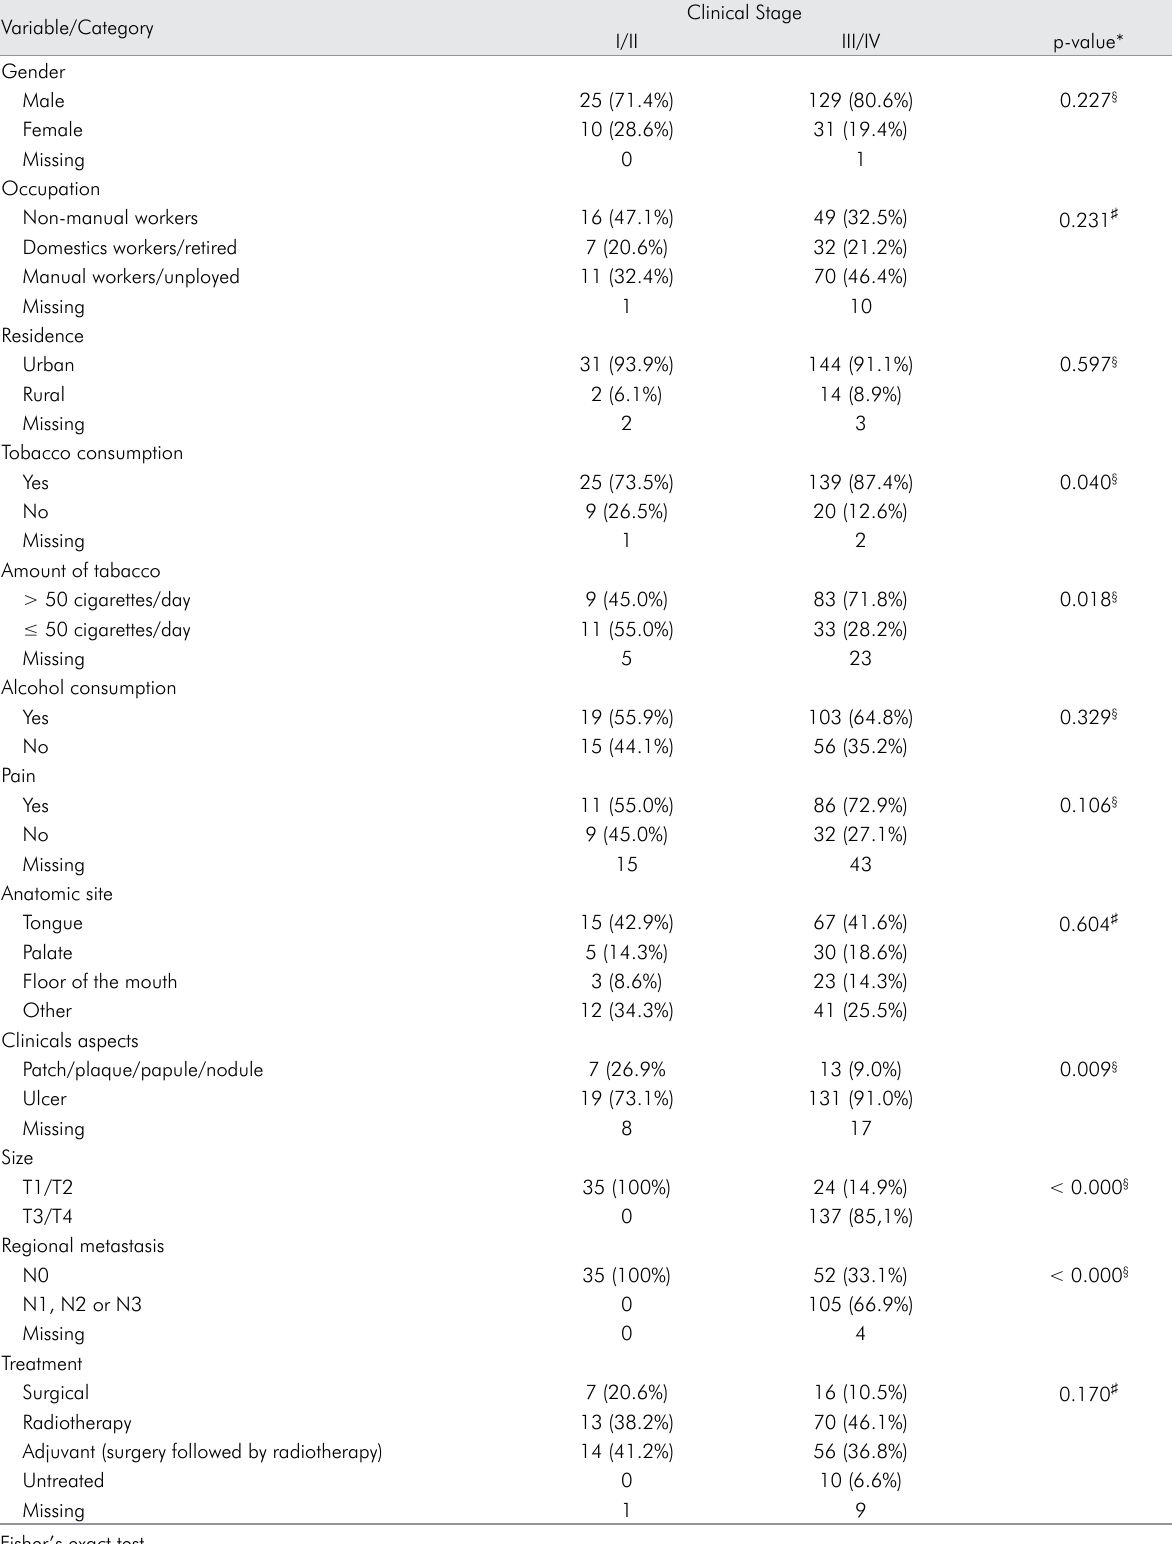
Table 3. Associations between clinical stage and variables. (N =